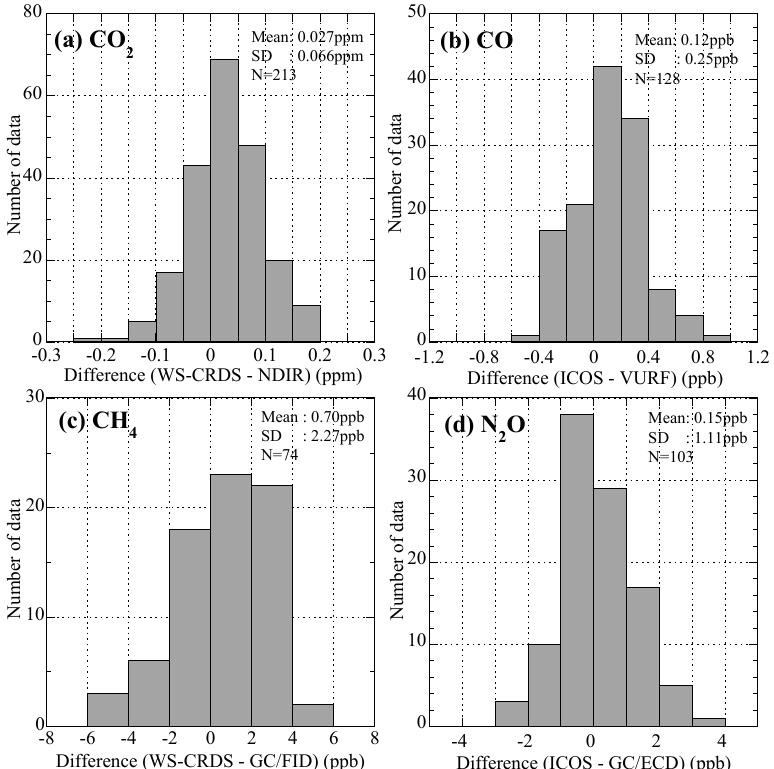
Fig. 5. Frequency distributions of the differences in air sample measurements for CO 2 between the WS-CRDS and the NDIR analyzers (a) , CO between the ICOS and the VURF analyzers (b) , CH 4 between the WS-CRDS and the GC/FID analyzers (c) , and N 2 O between the ICOS and the GC/ECD analyzers (d) . The ranges of mole fractions in the air sample are 387–398ppm for CO 2 , 66–126ppb for CO, 1796–1879ppb for CH 4 , and 320–327ppb for N 2